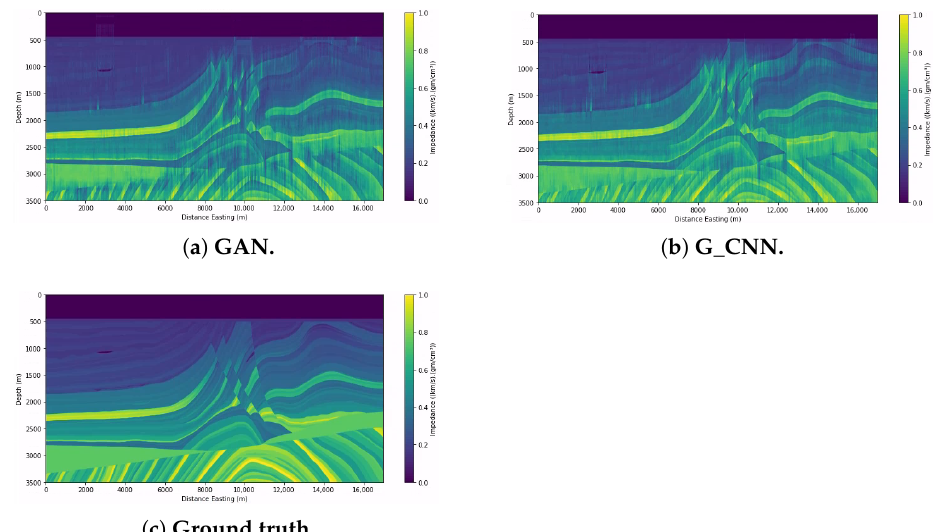
Figure 13. Prediction results for impedance sections for testing from the Marmousi2 dataset (with noisy